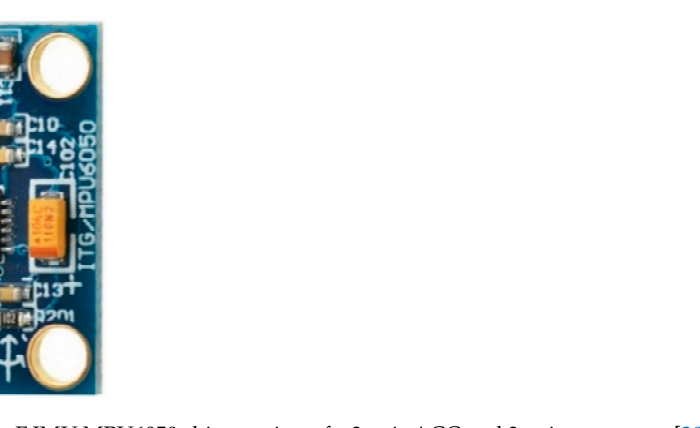
Figure 9. The six DoF IMU MPU6050 chip consists of a 3-axis ACC and 3-axis gyroscope [20,35,38,83]. Another updated IMU 6050 was obtained by adding the three-axis magnetometer effect on the existing six DoF IMU. This new version is known as the MPU 9250, with prices ranging from $15 to $20. This new device is now based on a microelectromechanical system having the ability to detect and operate on magnetic fields. MPU 9250, given below in Figure 10, provides a three-axis gyroscope, three-axis accelerometer, and three-axis magnetometer. Using 9 DoF IMU, hand orientation and movement for sign language gestures can easily be analyzed. MPU 9250 version of IMU proved better than its previous versions, including MPU 9150 in energy and power